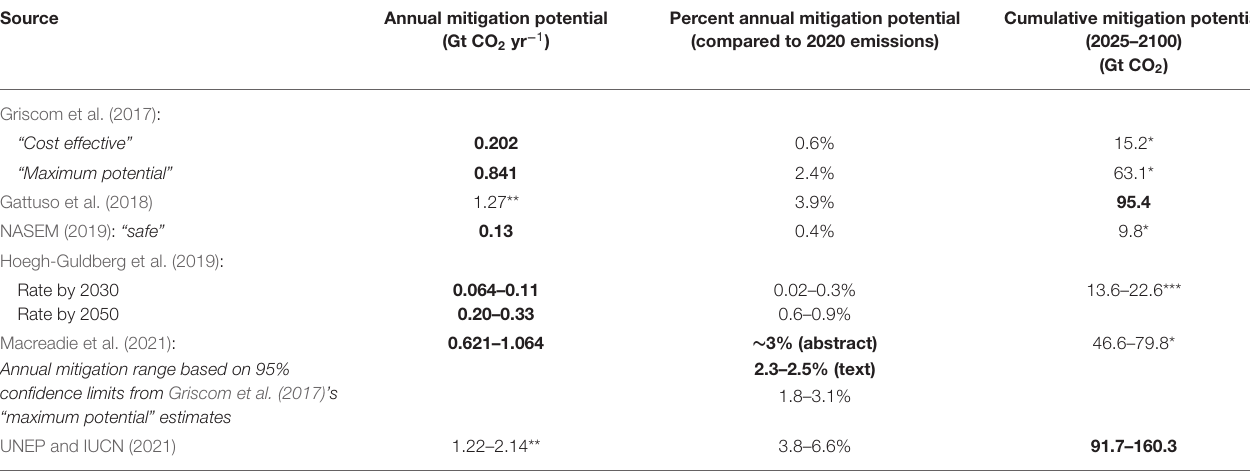
TABLE 1 | Global mitigation potential estimates for CBCE restoration (excluding emission reductions through